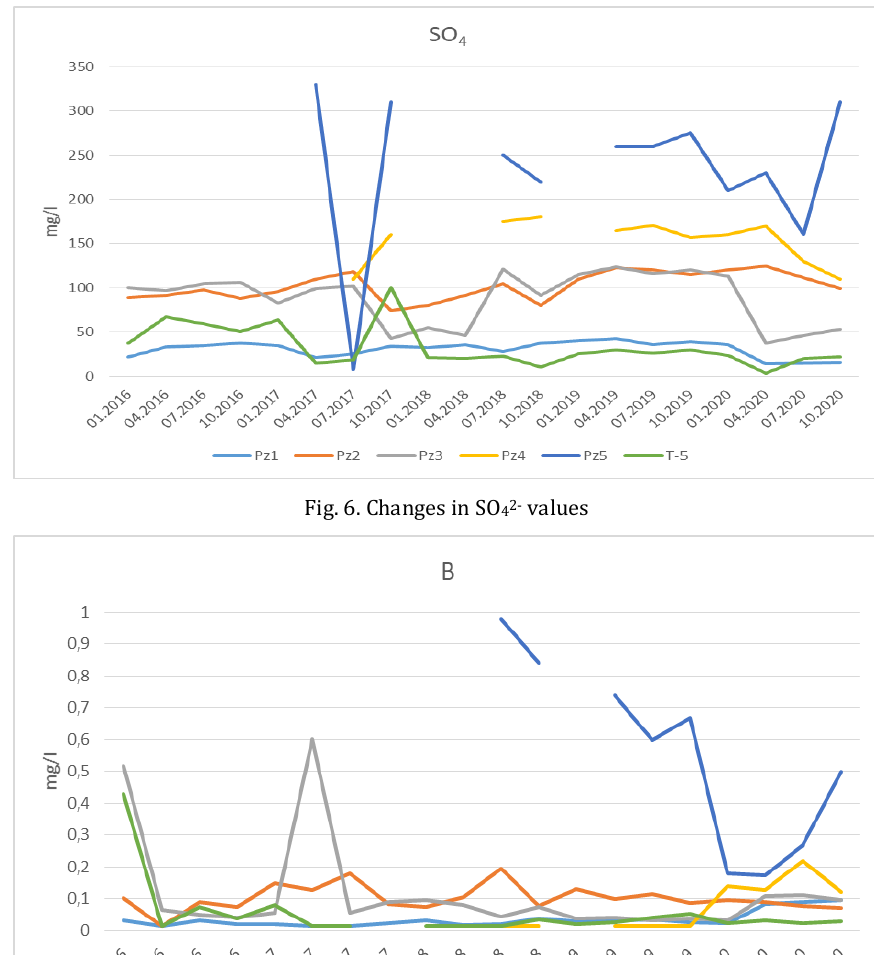
Fig. 7. Changes in B values